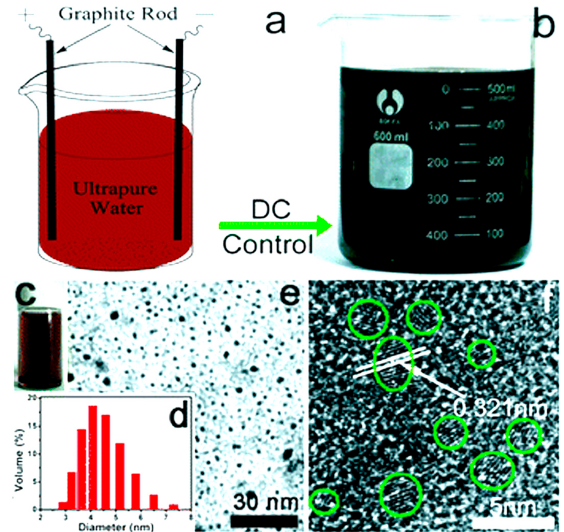
Figure 4. ( a ) Reaction equipment for the preparation of C-dots; digital image of C-dots solution ( b ) before treatment; ( c ) after treatment; ( d ) DLS histogram of C-dots; ( e ) TEM; and ( f ) HRTEM image of C-dots. Reproduced with permission from [38]. Copyright (2012) Royal Society of Chemistry.